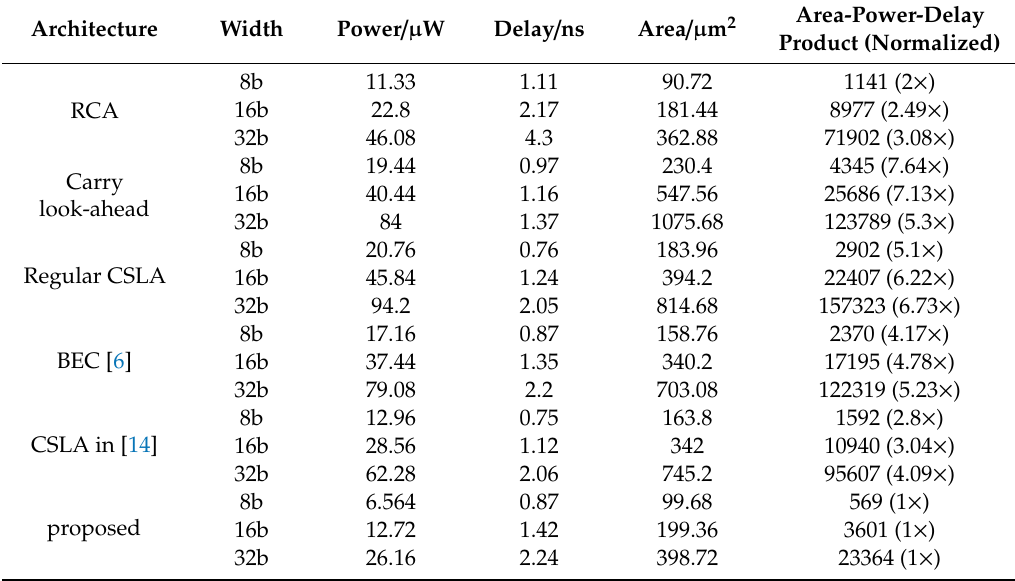
Table 2. Detailed comparison of the proposed CSLA, regular SQRT CSLA, and BEC-based CSLA.